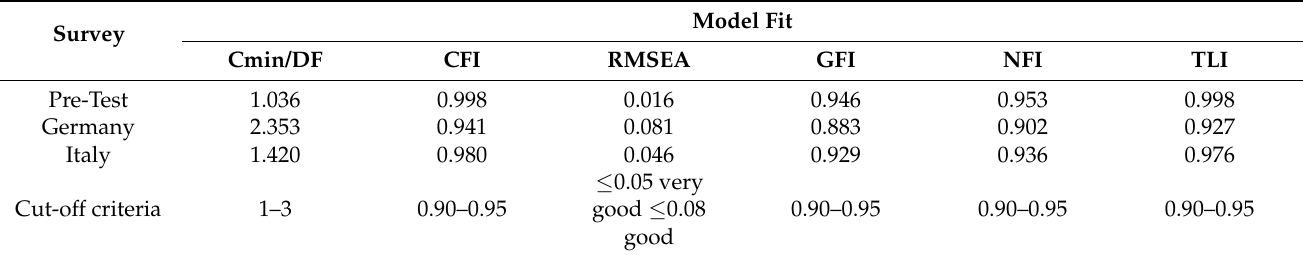
Table 4. Model fit (measurement and structural equation